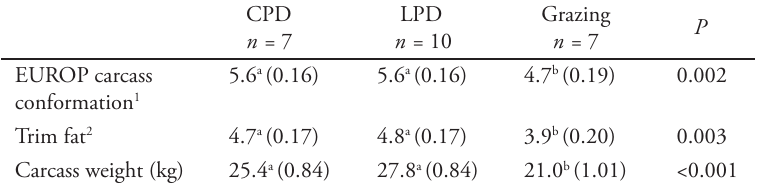
Table 2b. Carcass conformation, trim fat content and dressed carcass weight of reindeer calves fed different types of pellets compared to free ranging calves (least - square means and standard errors) CPD Grazing